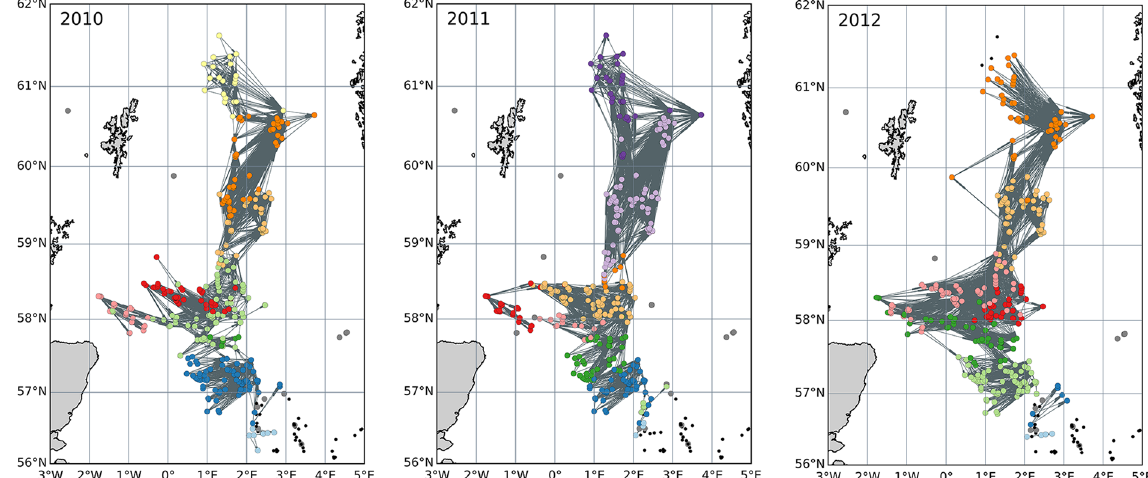
Figure 2. Inter-annual variability in network topology for the protected coral Lophelia pertusa . Highly connected clusters of installations are colour-coded based on Louvain modularity. Grey lines indicate structures that are connected. Grey dots indicate structures likely to have L . pertusa present; black dots represent structures unlikely to have L . pertusa present and thus excluded from all